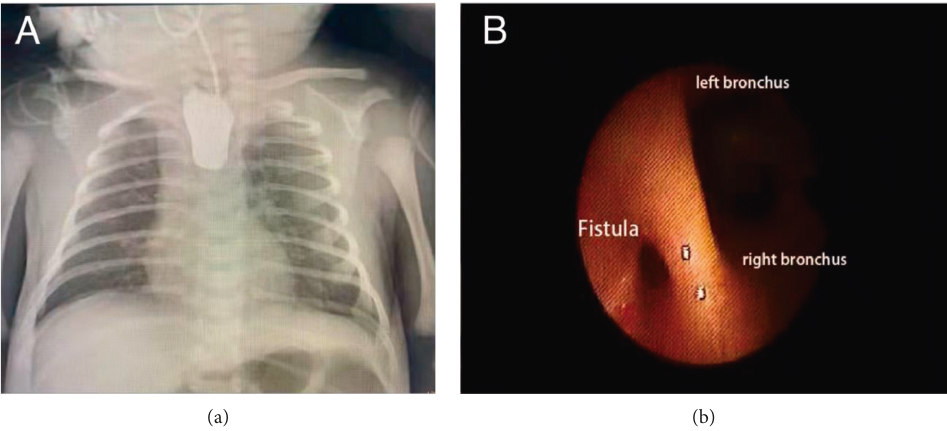
Figure 1: The contrast instilled in the esophageal pouch (a) and a fistula posterior to the left and right main bronchi